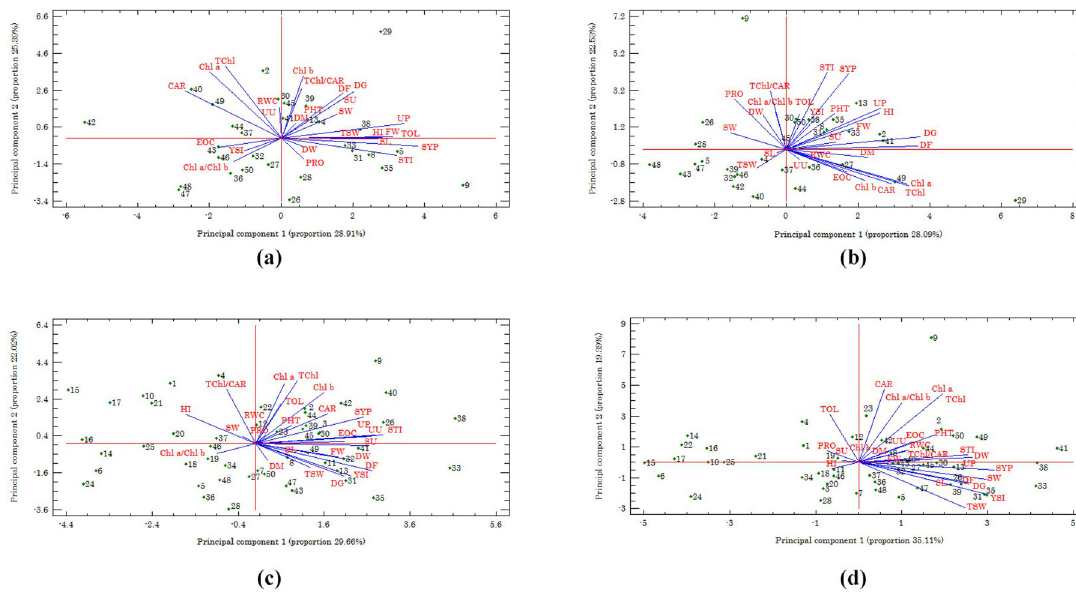
Fig 7. Distribution of the first two principal components (PC) of phenological, morphological, physiological traits, and selection indices of fennel under normal and deficit irrigations in 30 selfed (S1) (Fig 7A and 7B) and 49 open-pollinated populations (Fig 7C and 7D). CAR, Carotenoid content; Chl a , Chlorophyll a content; Chl b , Chlorophyll b content; Chl a /Chl b , Ratio of chlorophyll a to chlorophyll b content; DF, Days to flowering; DG, Days to germination; DM, Days to maturity; DW, Plant dry weight; EOC, Essential oil content; FW, Plant fresh weight; HI, Harvest index; PHT, Plant height; PRO, Proline content; RWC, Relative water content; SL, Seed length; STI, Stress tolerance index; SU, Number of seeds per umbelets; SW, Seed width; SYP, Seed yield per plant; TChl, Total chlorophyll content; TChl/CAR, Ratio of total chlorophyll to carotenoid content; TOL, Tolerance index; TSW, Thousand seed weight; UP, Number of umbels per plant; UU, Number of umbelets per umbel; YSI, Yield stability